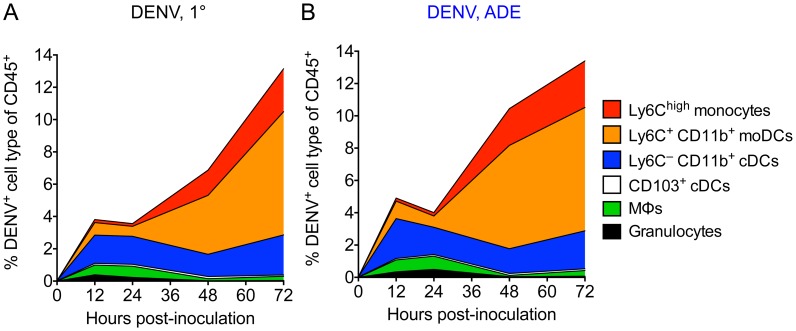
The main targets for DENV infection in the dermis over time.(A and B) Stacked area charts show mean distribution of all DENV+ CD45+ cells among cell populations in the dermis 12, 24, 48, and 72 hpi with DENV2 under 1° (A) or ADE (B) infection conditions. Individual populations from top to bottom: Ly6Chigh monocytes, Ly6C+ CD11b+ moDCs, Ly6C– CD11b+ cDCs, CD103+ cDCs, MΦs, and granulocytes. The depicted area for each population represents the % DENV-infected cells for this cell type of CD45+ cells. Data are pooled from 2-4 independent experiments (n = 6–12 per time-point and condition).